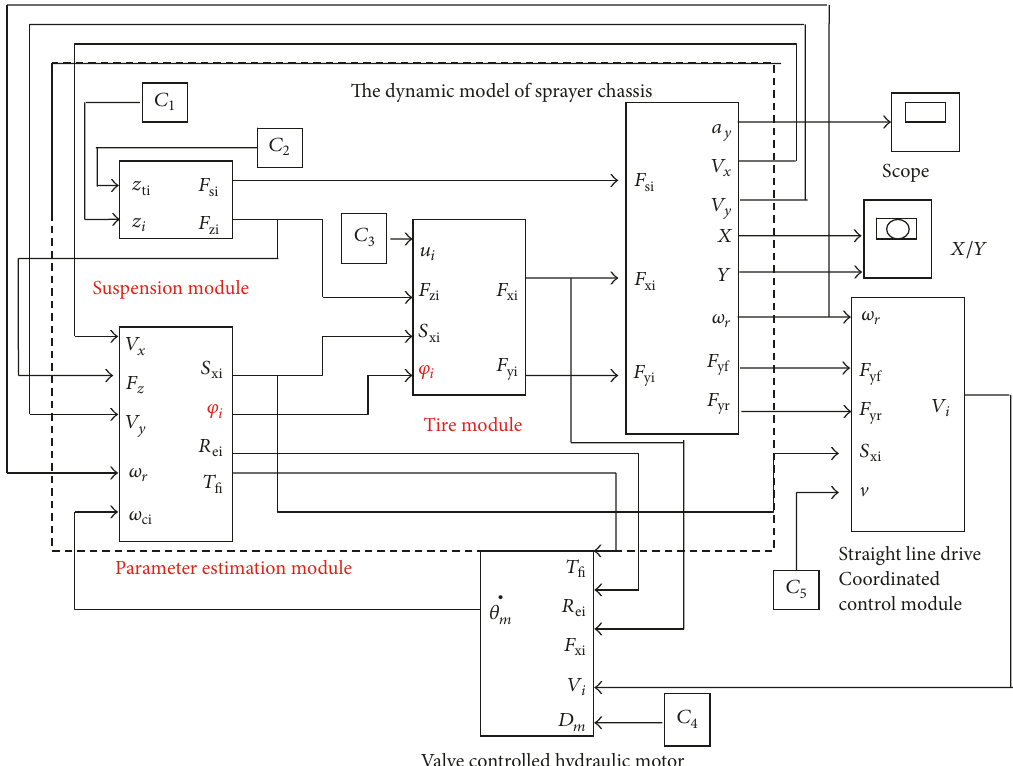
Figure 2: Simulation model of straight line drive coordinated control of sprayer chassis.